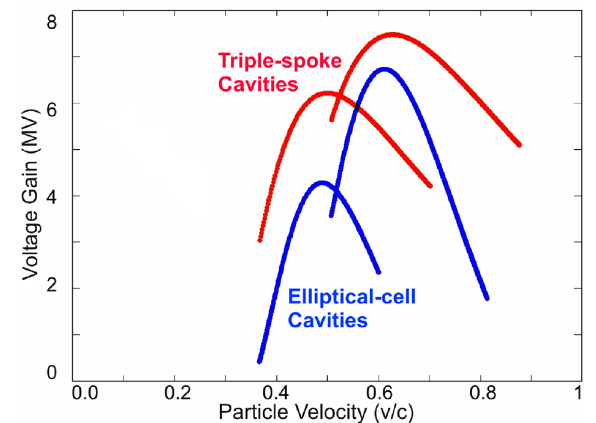
FIG. 2. (Color) Voltage gain per cavity as a function of particle velocity for two 345 MHz triple-spoke cavities compared with two 805 MHz elliptical 6-cell cavities, all operating at a peak surface electric field of 27 : 5 MV = m .